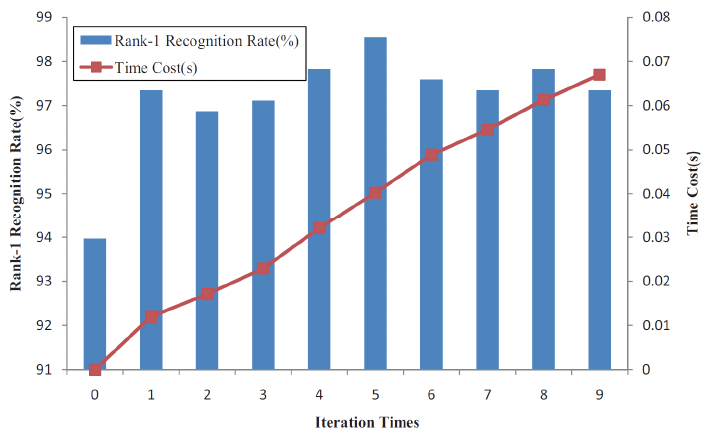
Figure 13. The performance of Iterative Closet Point (ICP) on the UND-J2 database with different iteration times utilized for normalization.